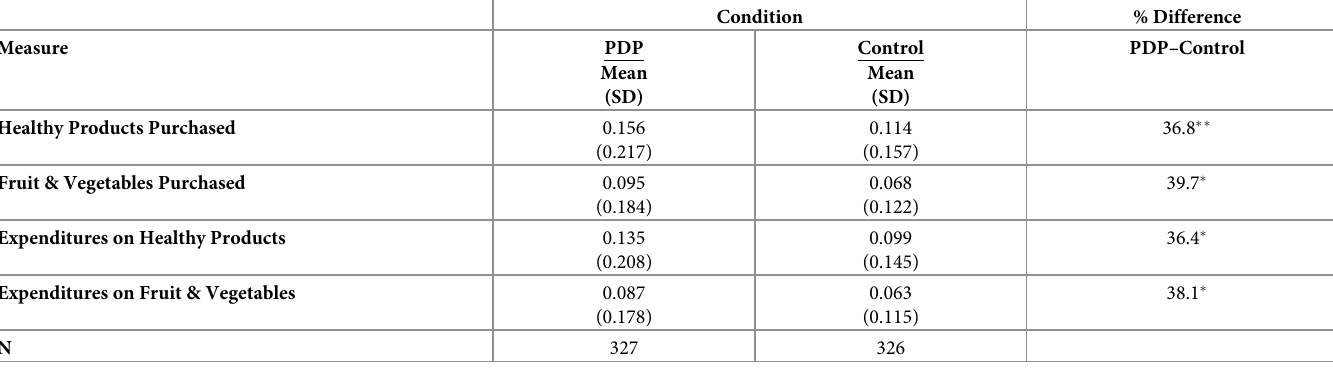
Table 1. Purchases of healthy items in pooled prompt condition versus control